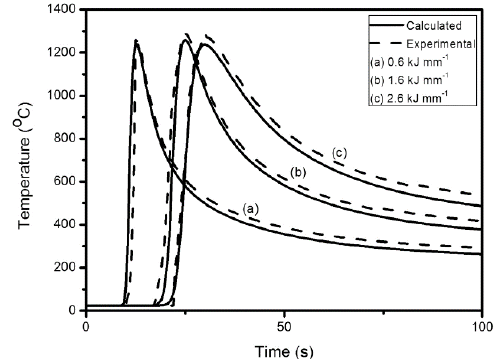
Figure 4. Comparison between calculated and measured thermal cycles.